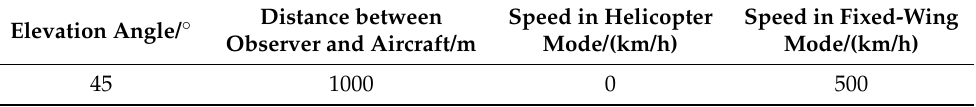
Table 4. Fixed parameters of 12 simulation cases considered in this paper. Distance between Elevation Angle/ ◦ Observer and